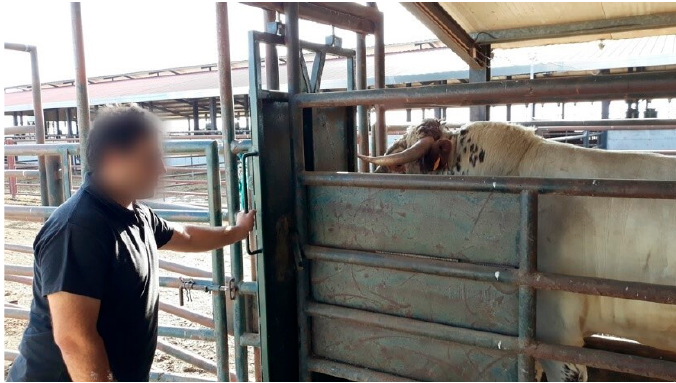
Figure 1. Evaluation of the chute exit [21].